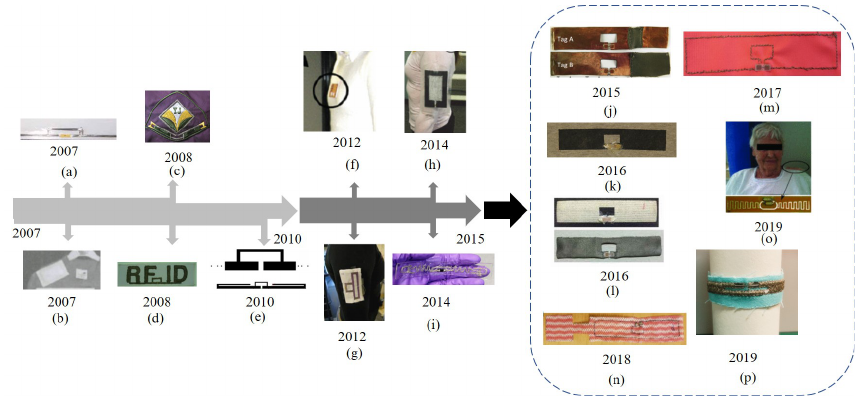
Figure 6. Brief history of textile UHF-RFID and sensing technologies. ( a ) Flexible electro-thread UHF-RFID tag antenna designed using the T-matching method, with a read range of about 2.4 m (adapted from ref. [23]). ( b ) Textile UHF-RFID tag for accessories trace and production process monitor, attached on a garment (adapted from ref. [56]). ( c ) Fabricated ’YJ’ symbol type textile UHF-RFID tag for exploring different shapes of embroidery tag antenna (adapted from ref. [57]). ( d ) Fabricated ’RFID’ symbol textile UHF-RFID tag for analyzing the changes of conductivity for different sewing methods (adapted from ref. [58]). ( e ) Textile UHF-RFID strain sensor for human bodily functions and movement monitoring, fabricated by screen printing the ink on stretchable PVC and on fabric substrates (adapted from ref. [11]). ( f ) Textile UHF-RFID strain sensor for human movement monitoring and feasibility of effective data interaction (adapted from ref. [59]). ( g ) Textile UHF-RFID tag for performance exploration, mainly validated by the read range (adapted from ref. [60]). ( h ) Textile UHF-RFID tag for positioning and localization through recording and analyzing on-body readability and Received Signal Strength (RSS) in an office environment (adapted from ref. [61]). ( i ) E-fiber UHF-RFID broadband tag for tie health information monitor, fabricated on conductive textiles and embedded into polymer (adapted from ref. [62]). ( j ) Textile UHF-RFID strain sensor for exploring the relation between the antenna elongation and its backscatter strength, based on a stretchable antenna made of conductive fabrics (adapted from ref. [63]). ( k ) Graphene-based UHF-RFID tag on a fabric substrate for exploring feasibility and reliability of the low-cost and eco-friendly graphene tag (adapted from ref. [12]). ( l ) Health-care-based UHF-RFID sweat sensor for sweat rate measurements in exercise, by comparing the silver plated sample and the graphene-printed sample (adapted from ref. [6]). ( m ) Health-care-based textile UHF-RFID moisture sensor for body moisture sensing (adapted from ref. [64]). ( n ) Environment-based textile UHF-RFID moisture sensor for humility detection, with a sensor part and an antenna part (adapted from ref. [65]). ( o ) Health-care-based textile UHF-RFID accelerometer sensor for alerting on hospitalized patient bed exits with a super low resolution (adapted from ref. [9]). ( p ) Textile UHF-RFID tag for exploring the impact from geometrical variations and deformations (adapted from ref.